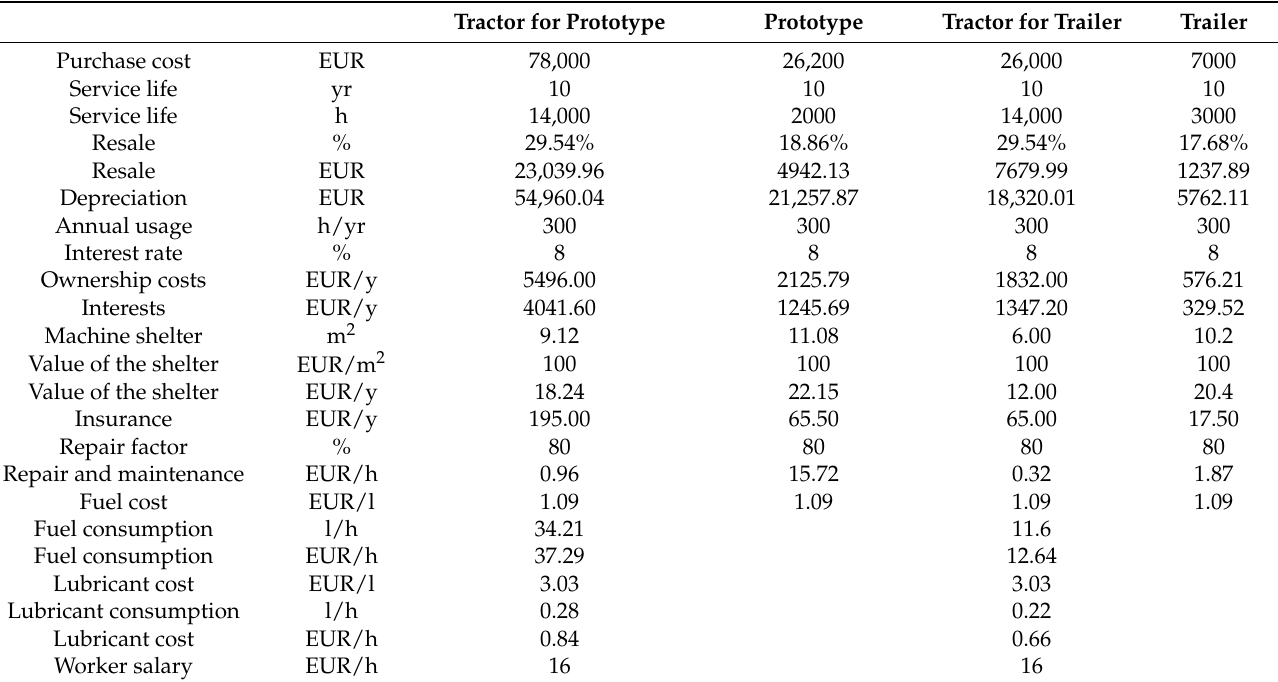
Table 3. Parameters and values applied for cost